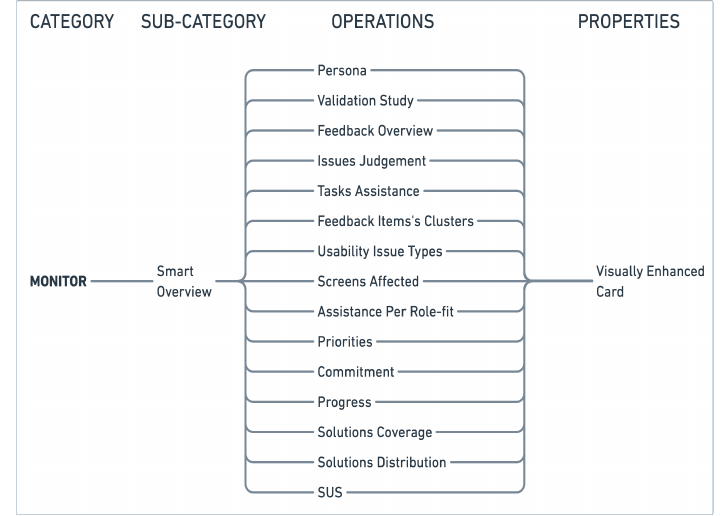
Figure 5. The monitor category, sub-category, operations, and